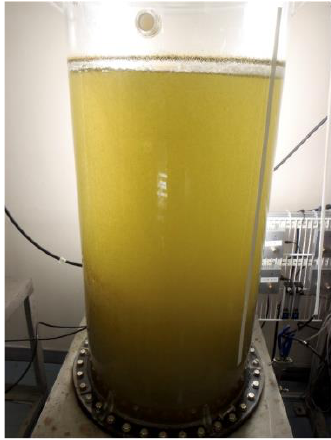
Figure 2. Nostoc verrucosum cultured in a cylindrical tank under a fluorescent